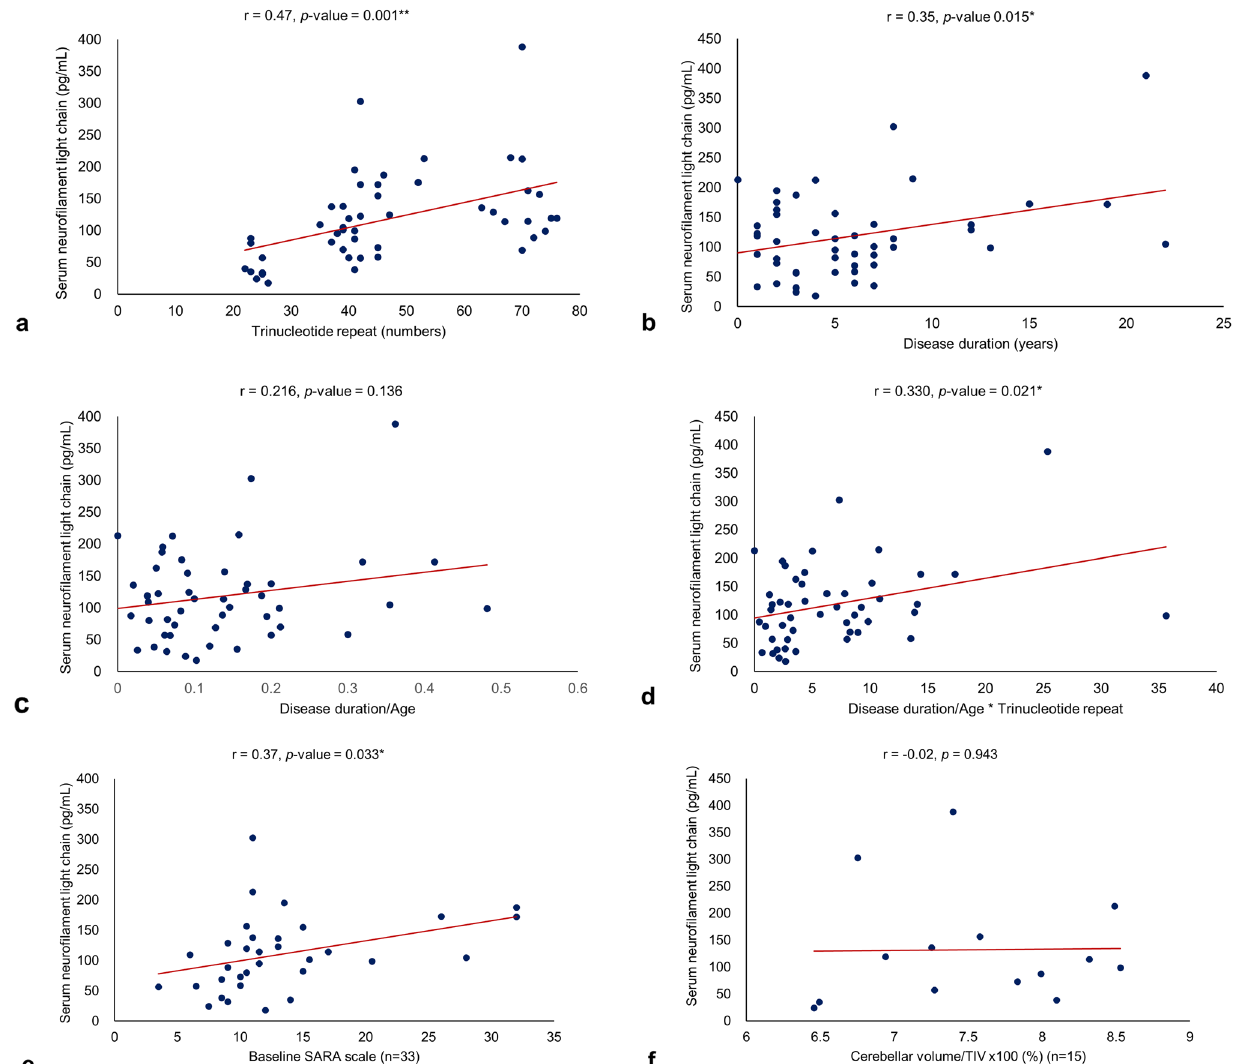
Figure 2. Correlation of serum neurofilament light chain with clinical severity of autosomal-dominant SCA. (a) The trinucleotide repeat number and serum neurofilament light chain showed a positive correlation (r = 0.47, p -value = 0.001). (b) Disease duration and the serum neurofilament light chain showed a positive correlation (r = 0.35, p -value = 0.015). (c) Disease duration and age were not significantly correlated (r = 0.22, p -value = 0.136). (d) The disease duration/age × trinucleotide repeat number showed a positive correlation with serum NfL (r = 0.33, p -value = 0.021). (e) The SARA score and serum neurofilament light chain were positively correlated (n = 33; r = 0.37, p -value = 0.033). (f) The percentage of cerebellar volume within TIV did not have a significant correlation with serum NfL (n = 14; r = 0.02, p -value = 0.957). ** is for p -value < 0.01, and * is for p -value <